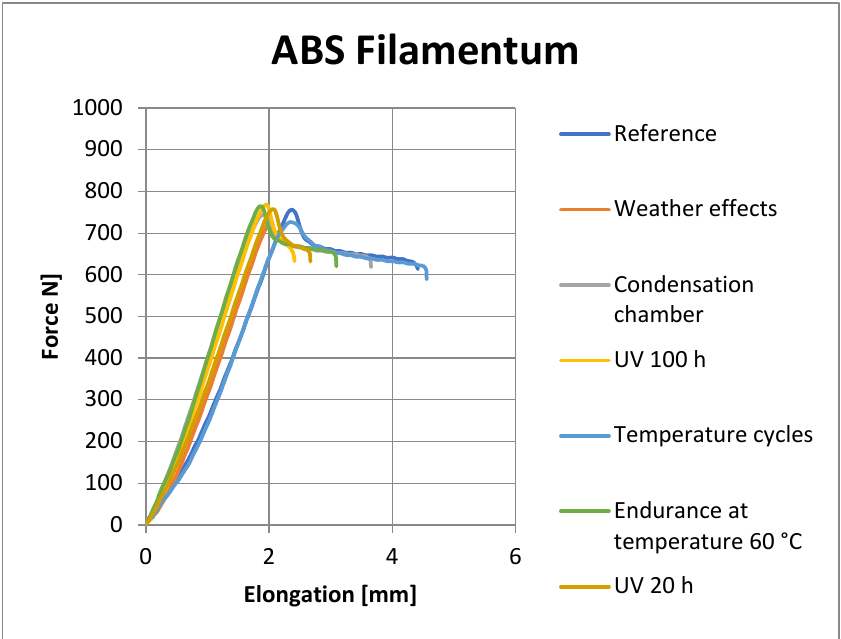
Figure 10. Tensile curves of ABS Fillamentum samples.